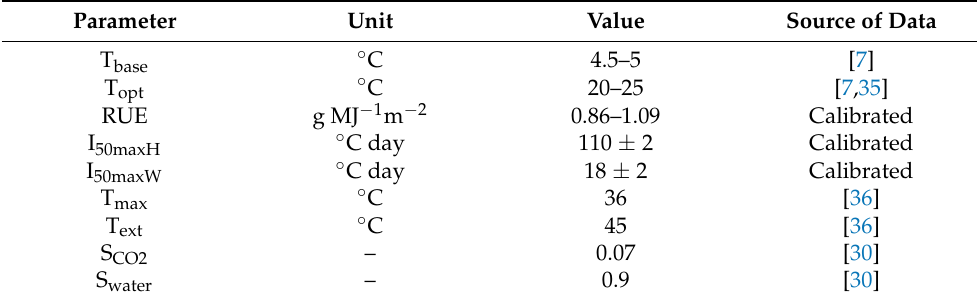
Table 3. The SIMPLE model species parameters of